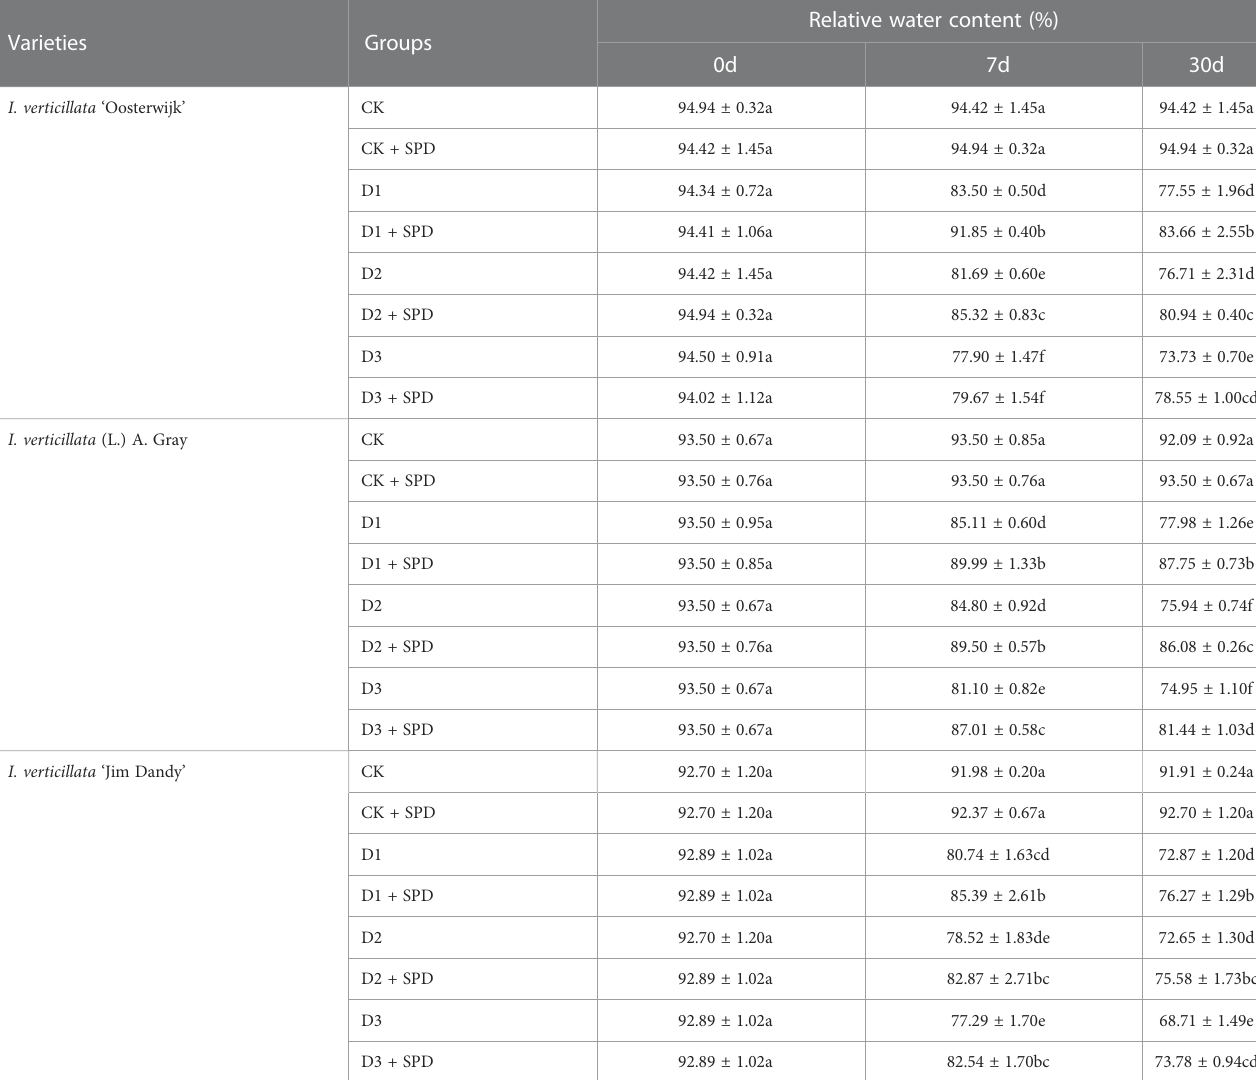
TABLE 2 Changes in the relative water content of Ilex verticillata leaves under drought and spermidine treatments.